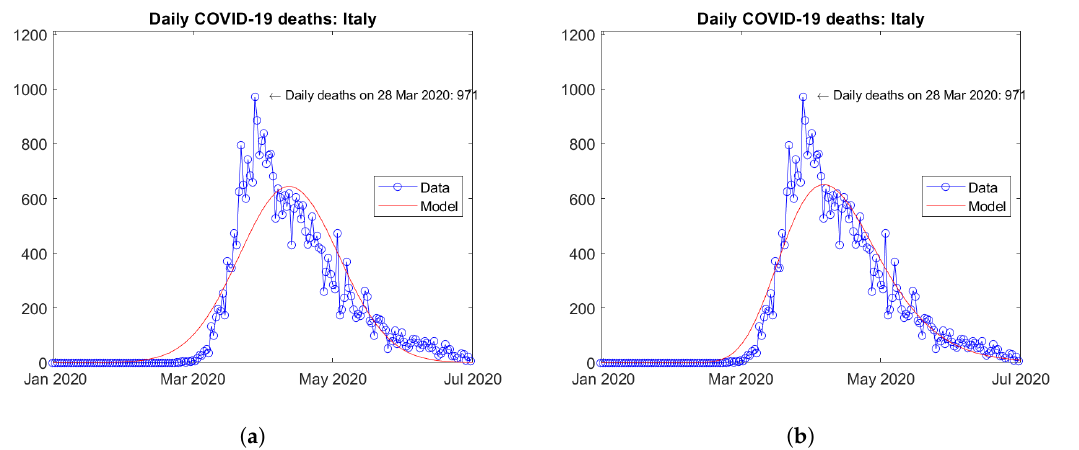
Figure 1. Fitting of daily deaths data from Italy: ( a ) Gaussian distribution function, ( b ) lognormal distribution